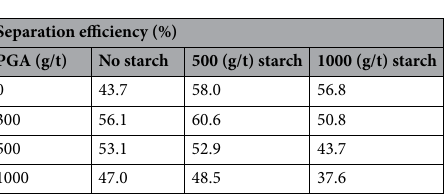
Table 3. Variation of Separation Efficiency with and Without PGA and